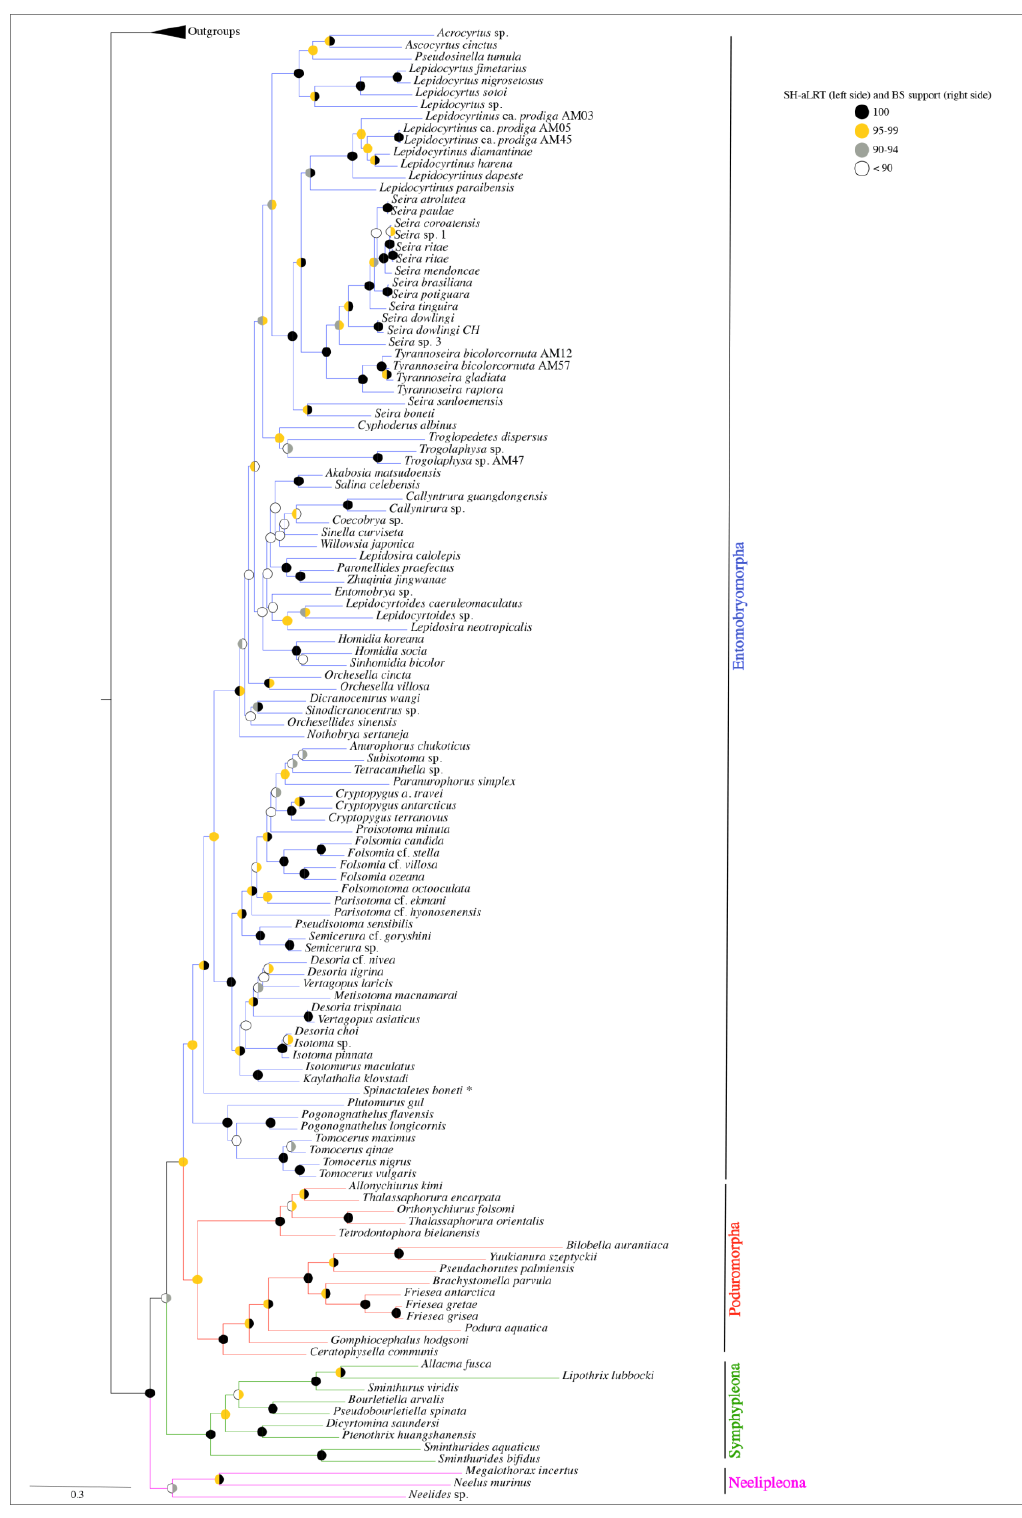
Figure 1. Phylogeny of Collembola inferred from Maximum Likelihood unpartitioned dataset substitution model mtZOA+F+R10 (ML_1). Node circles represent SH-aLRT support (left side) and bootstrap values (right side), respectively; colors represent the following scores: black = 100; yellow = 95 – 99.9; grey = 90 – 94.9; white < 90. Branches of each Collembola order are represented in different colors.